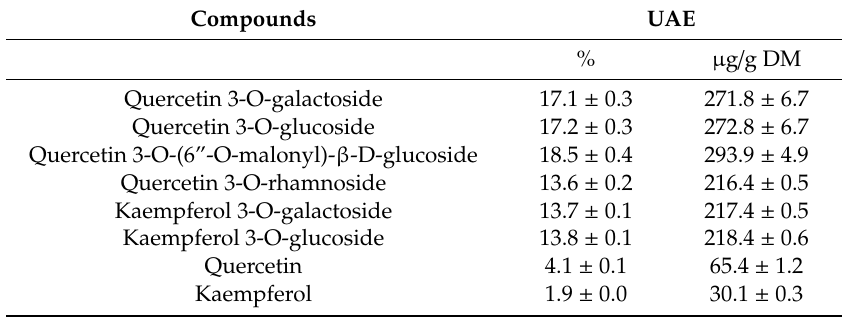
Table 7. Flavonol composition of M. oleifera leaves (mean value ± standard deviation, n = 3).